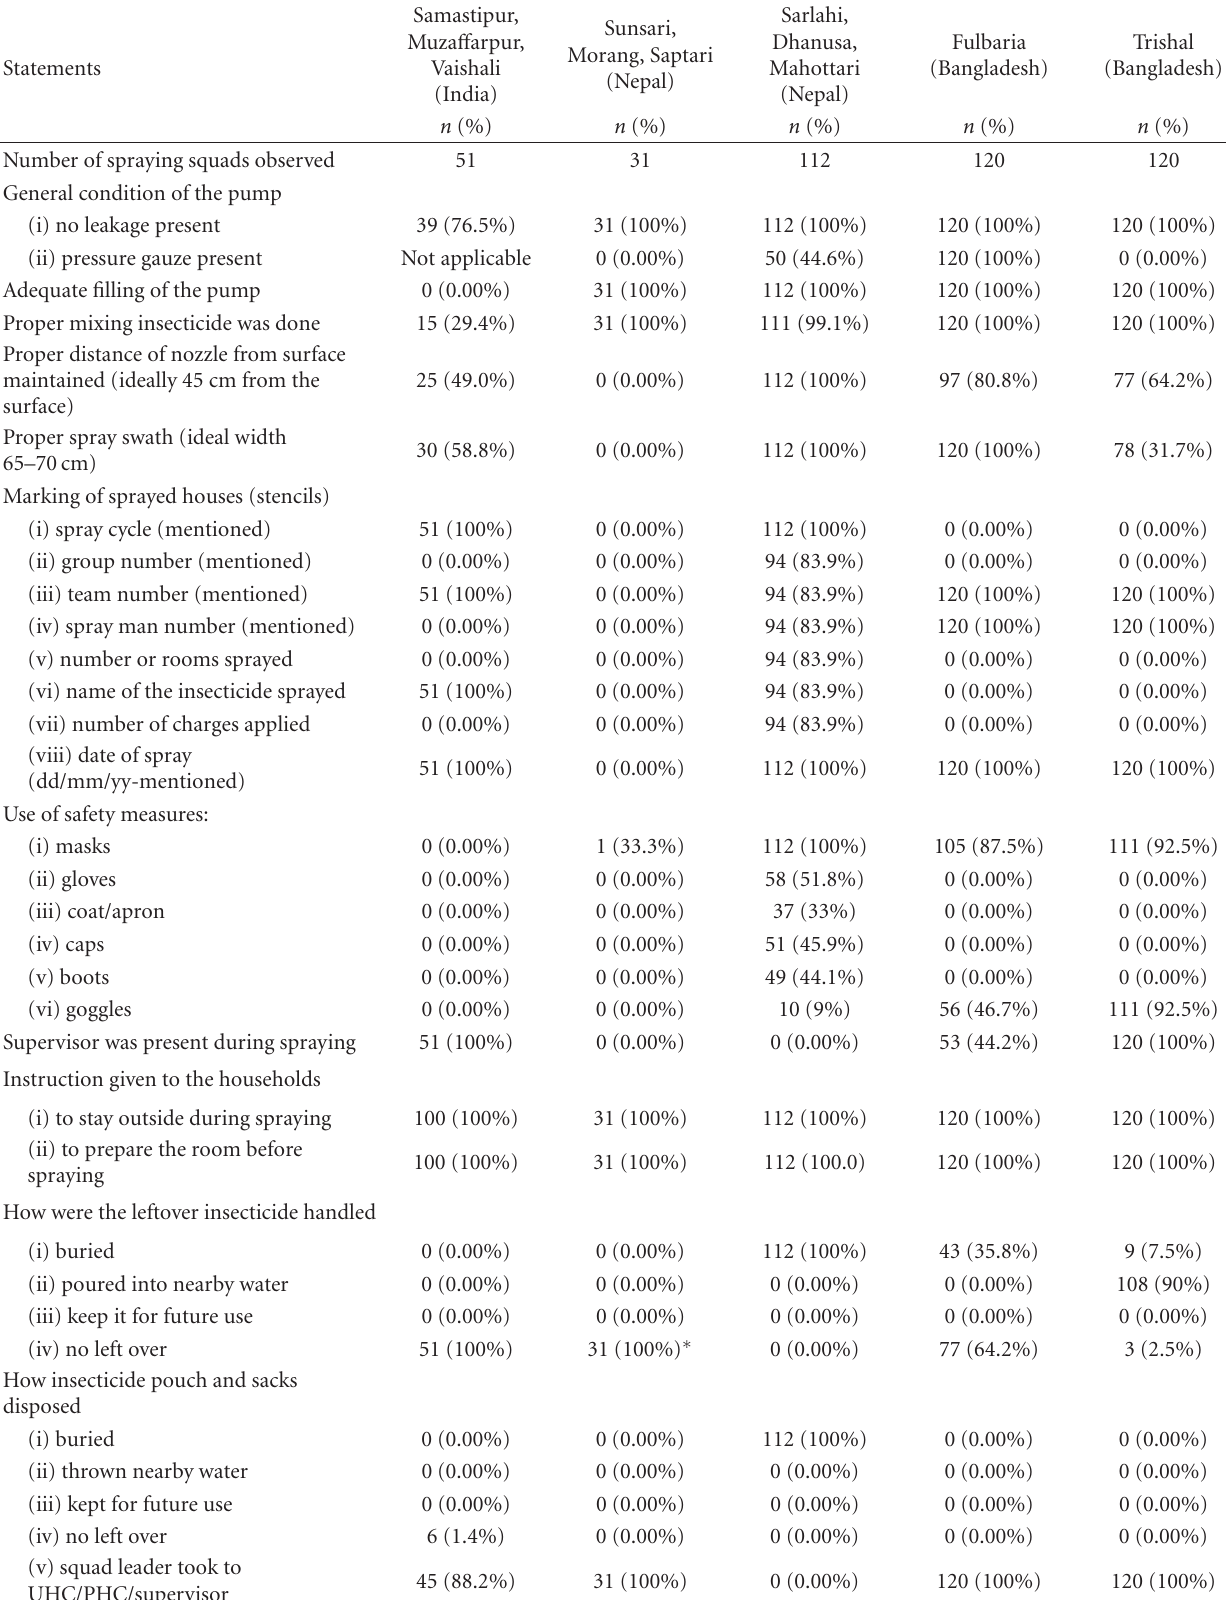
Table 2: Findings of process indicators: observation of spraying squad at community